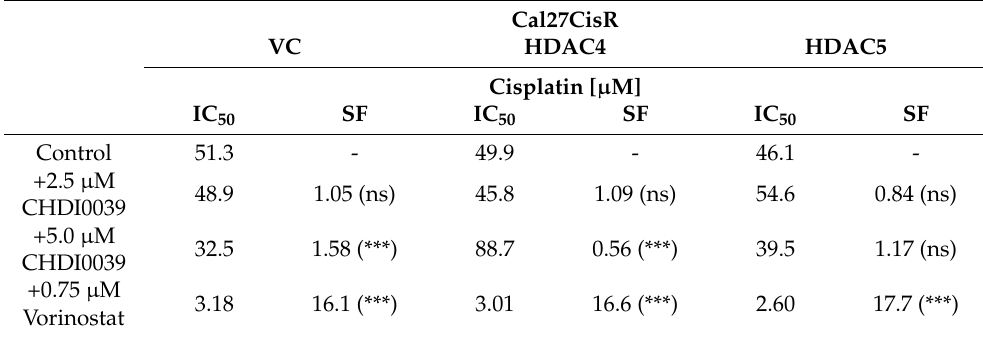
Table 5. Coincubation of CHDI0039 with bortezomib sensitizes Cal27CisR cells with overexpression of HDAC4, HDAC5, or vector control (VC) to bortezomib. Shown are IC 50 values of bortezomib [nM] and shift factors [SF]. † = *** ( p ≤ 0.001). SD ≤ 15% of the mean. Values represent means